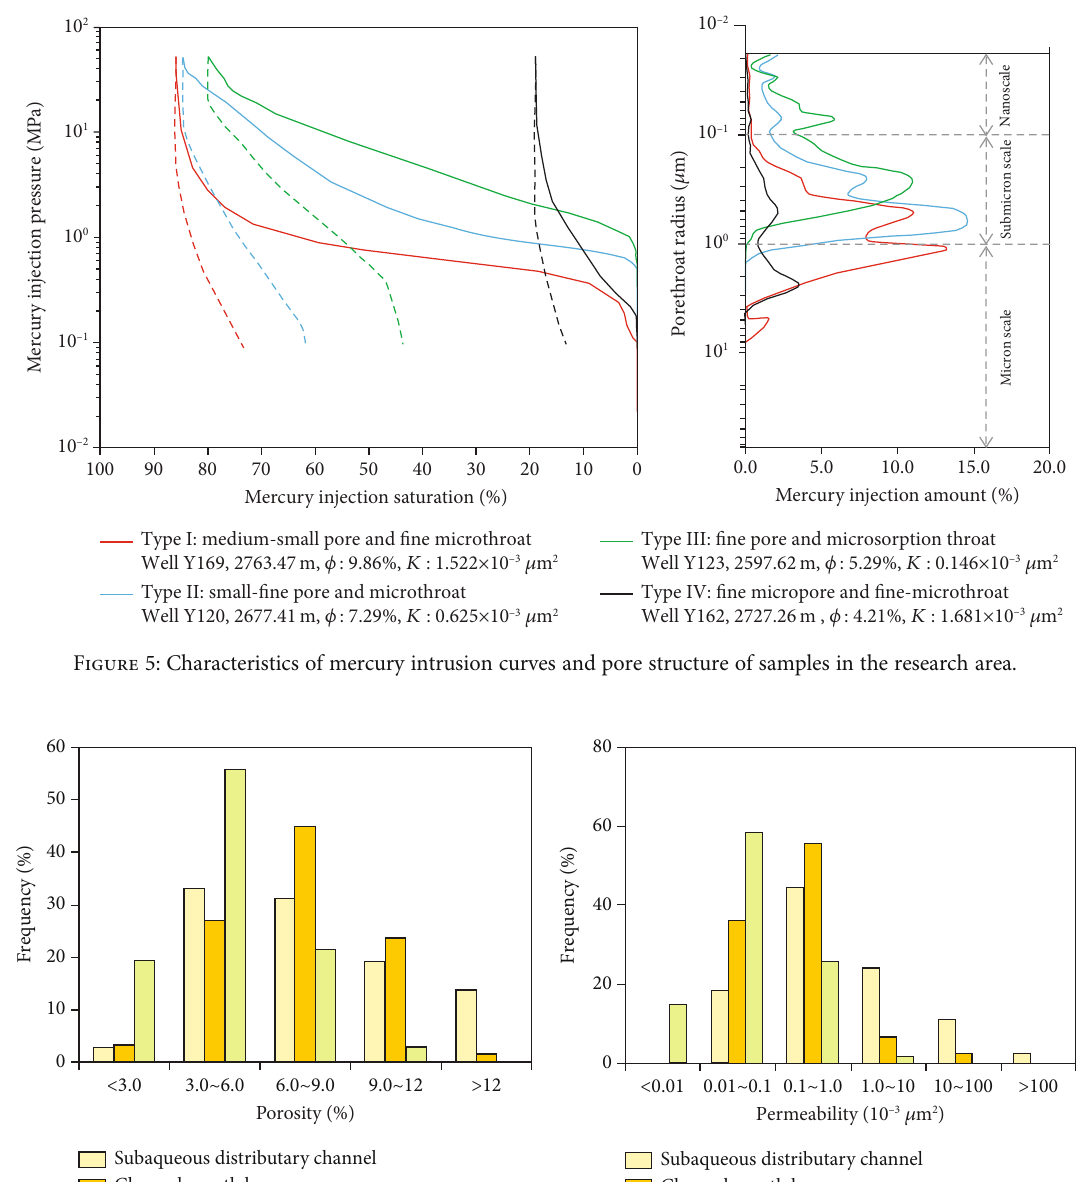
(1) E ff ects of Compaction and Pressure Solution on Reservoir Porosity . The deeply buried quartz in the Shan-2 Member (Figure 8(a)). Flexible detrital particles (such as mica and argil- laceous debris) are bent and orientated or semiorientated due to compaction and pseudomatrixization. It is commonly seen that grains show long contact due to quartz secondary over- growth. Concave-convex or suture contact is also observed.